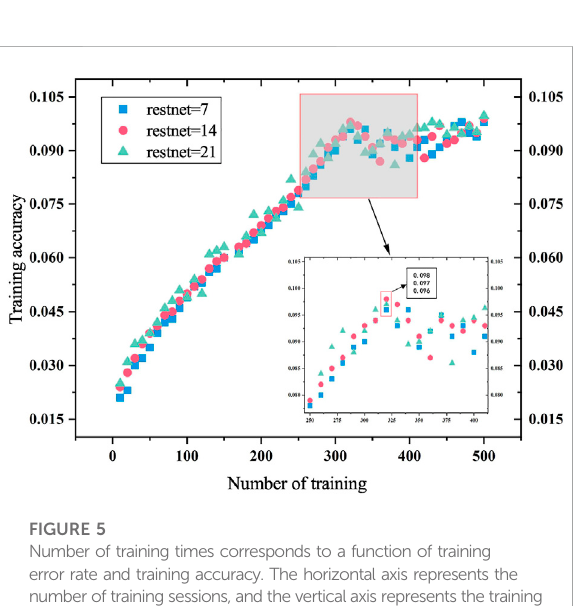
FIGURE 5 Number of training times corresponds to a function of training error rate and training accuracy. The horizontal axis represents the number of training sessions, and the vertical axis represents the training error rate and accuracy rate. Restnet=7, restnet=14, and restnet=21aremarkedwithblue,red,andgreen,separately.Forintuitive viewing, zoom plots are set up to make it easier to observe the data.